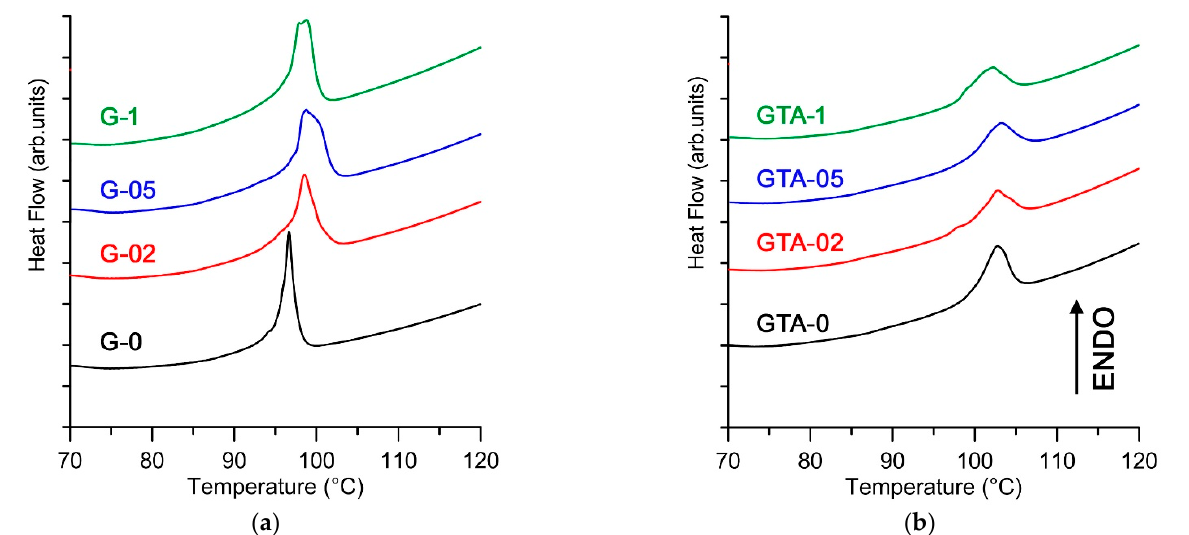
Figure 5. DSC thermograms recorded from ( a ) G films and ( b ) GTA films show the presence of an endothermic peak due to collagen triple helix denaturation. Table 2. Microcalorimetric data: DSC enthalpy variation and temperature of the endothermic tran- sition.